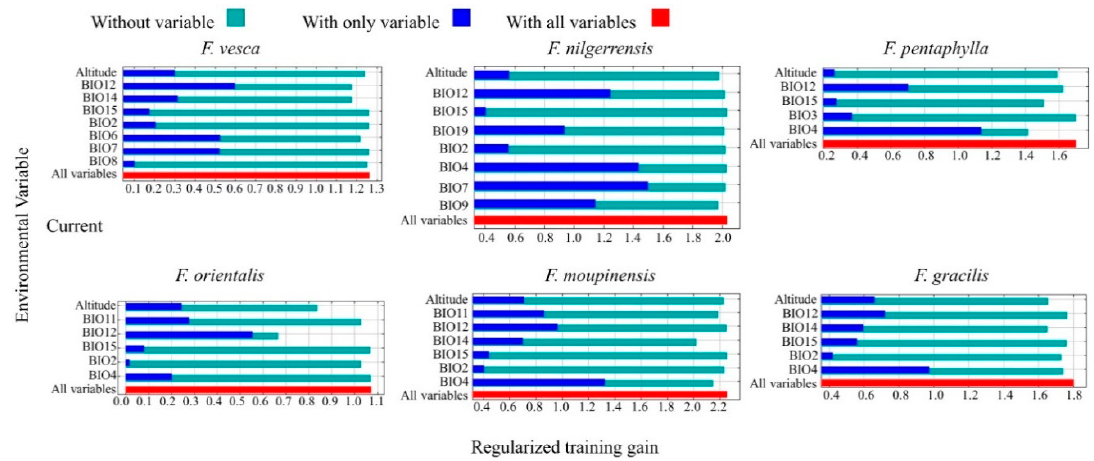
Figure 3. Jackknife test of regularized training gain for six wild strawberry species under the current climate scenario. “Current” represents current scenario (1970 to 2000). BIO2, mean diurnal range; BIO3, isothermality; BIO4, temperature seasonality; BIO6, min temperature of coldest month; BIO7, temperature annual range; BIO8, mean temperature of wettest quarter; BIO9, mean temperature of driest quarter; BIO11, mean temperature of coldest quarter; BIO12, annual precipitation; BIO14, precipitation of driest month; BIO15, precipitation seasonality; BIO19, precipitation of coldest quarter.